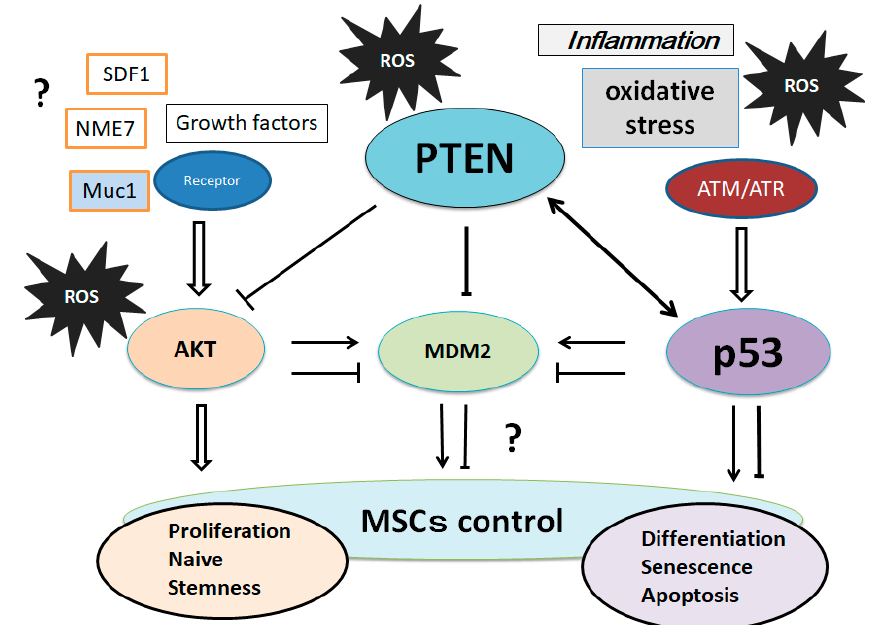
Figure 3. Suggestion of various molecular regulatory loops involving the PTEN-p53-AKT-MDM2 network on the controls of MSCs is shown. Interactions are shown as arrows to mean activation, while hammerheads mean inhibition. Expression of these molecules is regulated by genetic, epigenetic, and transcriptional changes, which may result in the MSCs’ regulation. Note that some critical pathways have been omitted for clarity.